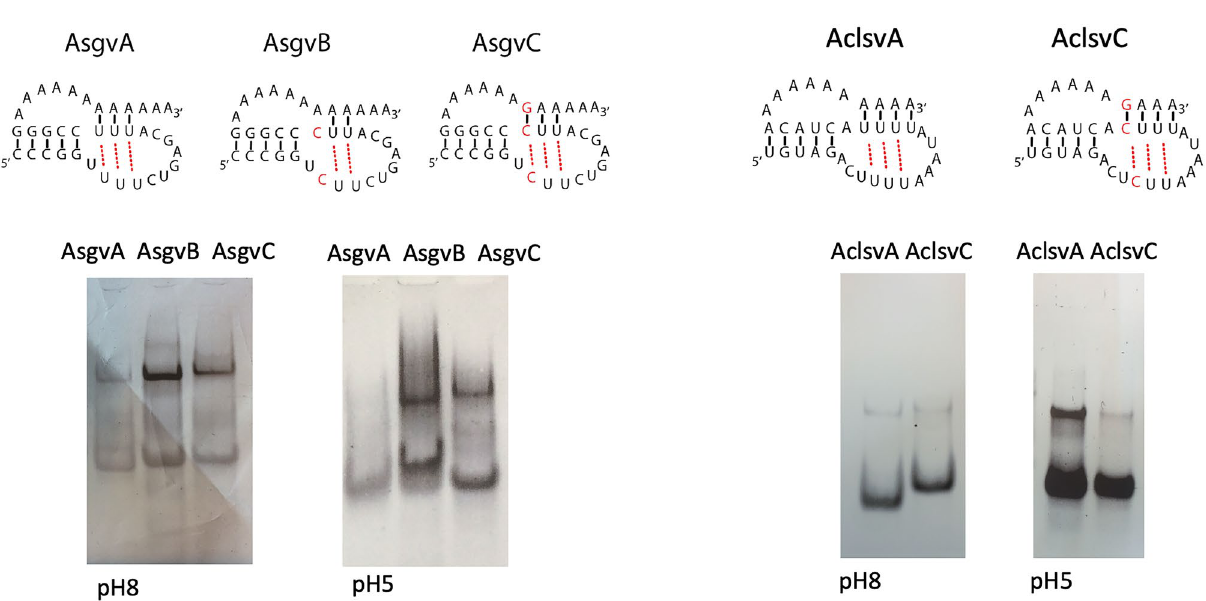
Figure 8. Native gel electrophoresis at pH 8 and 5 of Apple stem grooving capillovirus (AsgvA, B, C) and Apple chlorotic leaf spot trichovirus (AclsvA and C) pseudoknot RNAs. RNAs were visualized by EtBr